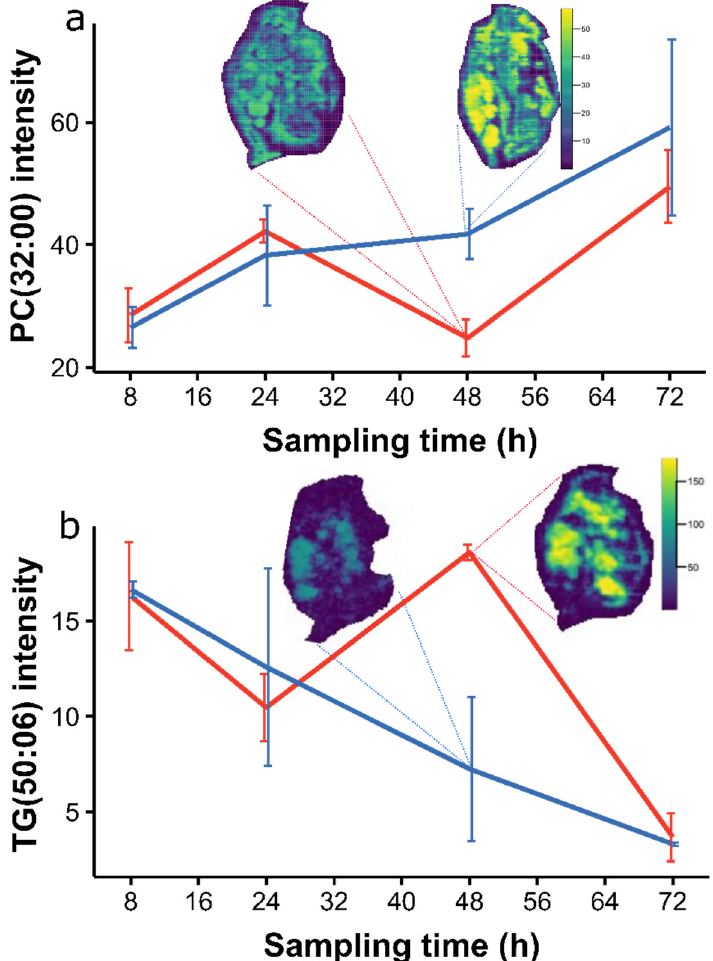
Figure 8. Line graphs showing the differences in abundance of a representative phosphatidylcholine and triacylglyceride; ( a ) PC(32:00) at m/z = 756.5521, and ( b ) TG(50:06) at m/z 861.6503, in control (blue) and bisphenol-A exposed (red) Daphnia magna eggs across the seventh adult instar—specifically 8, 24, 48, and 72 h after the sixth brood. The error bars represent a 95% confidence interval. The ion images are overlaid on each plot to visualize the distribution of each lipid across the whole animal as a function of BPA exposure 48 h into the instar. The colour scale indicates the relative abundance of each lipid.